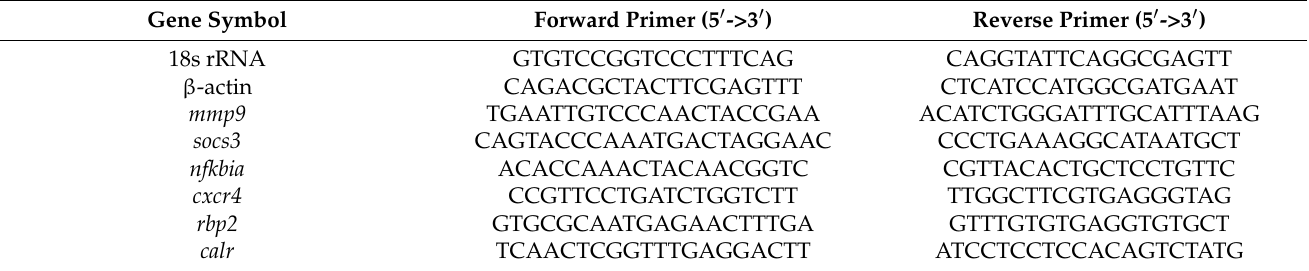
( b ) ( c ) Figure 1. Body surface symptoms of southern catfish infected with Plesiomonas shigelloides for 72 h. ( a ) Bleeding of anal fin of southern catfish infected with Plesiomonas shigelloides in PS vs. L-PS group. A: Southern catfish in L-PS group; B: southern catfish in PS groups. ( b ) Body surface symptoms of southern catfish. ( c ) Intestinal redness and swelling of southern catfish.